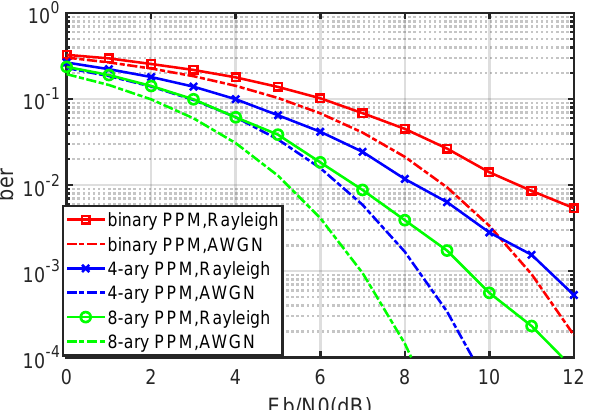
Figure 8. BER performance of a noncoherent Q-ary PPM suboptimal receiver in the Rayleigh fading channel and AWGN channel.